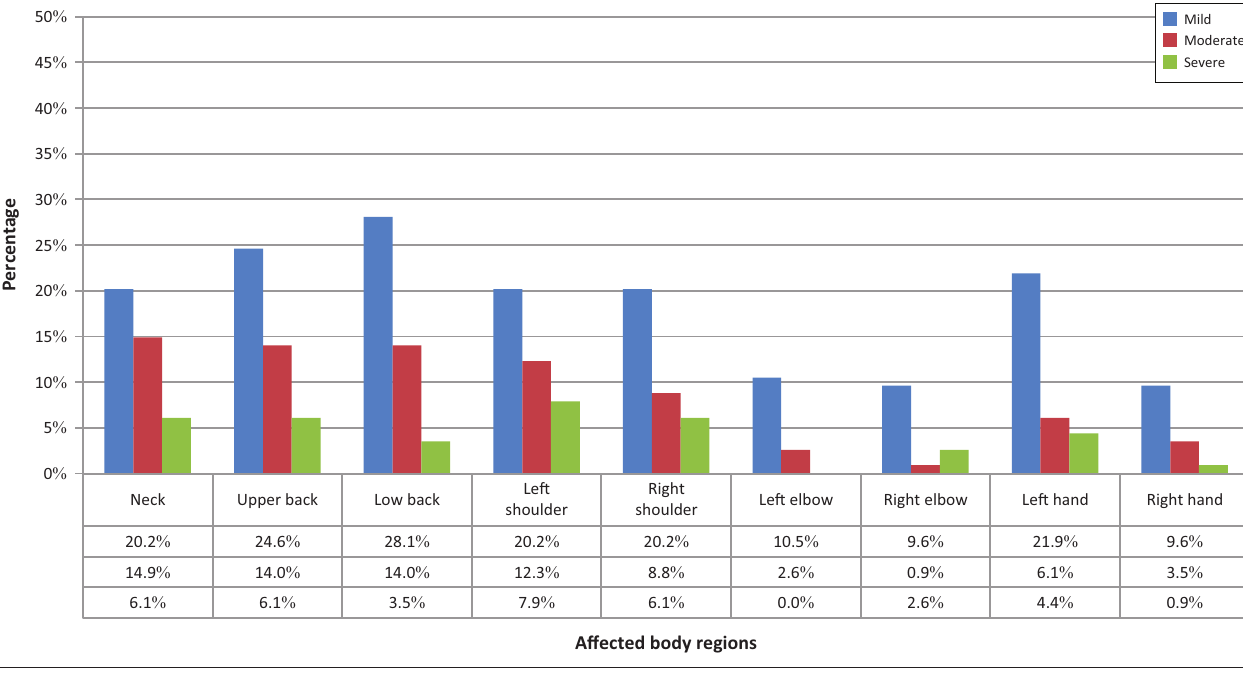
FIGURE 4: Illustrates the severity of the self-reported musculoskeletal problems across the nine anatomic body regions of the trunk and upper extremities. TABLE 3: Relationship between gender and the presence of musculoskeletal problems in the nine anatomic regions. Anatomic